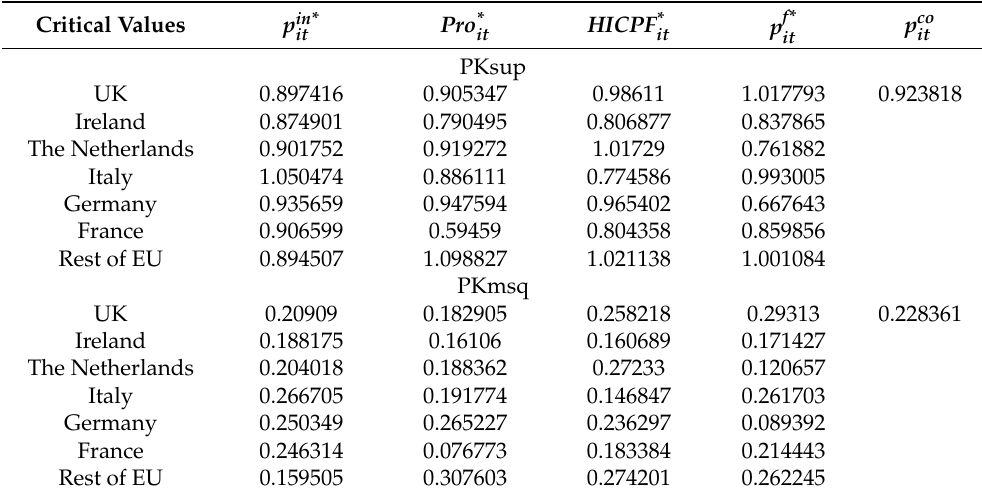
Table A2. Structural stability tests for intra-EU GVECM: critical values at 90% confidence intervals. Critical